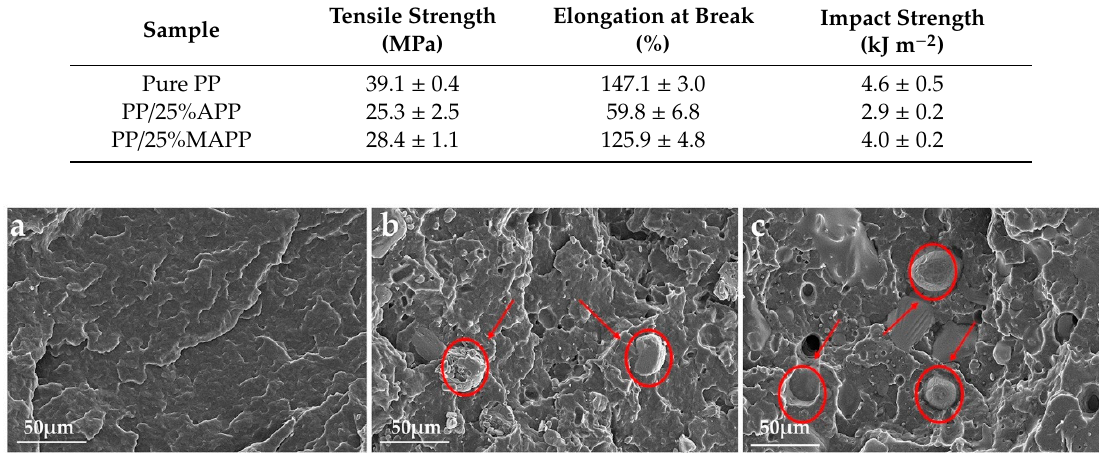
Figure 13. Typical stress-strain curves of pure PP and its flame-retardant blends. Table 5. Mechanical properties data of pure PP and its flame-retardant blends. Table 5. Mechanical properties data of pure PP and its flame-retardant blends.